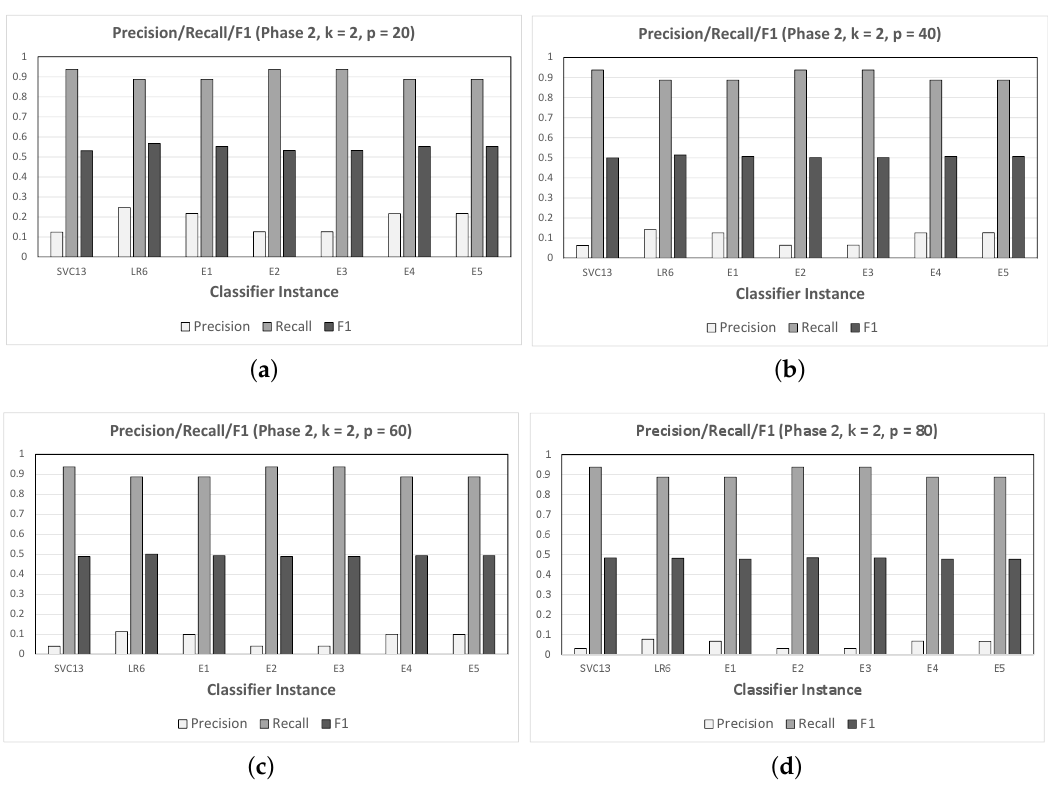
Figure 6. Evaluation of classification performance for chosen classifiers (two pure, five ensemble) over 54 users plus 2 duplicates engineered by splitting two of the original users, varying the number of pairs p sampled at random (guaranteed to contain the duplicate pairs): ( a ) p = 20, ( b ) p = 40, ( c ) p = 60, and ( d ) p =